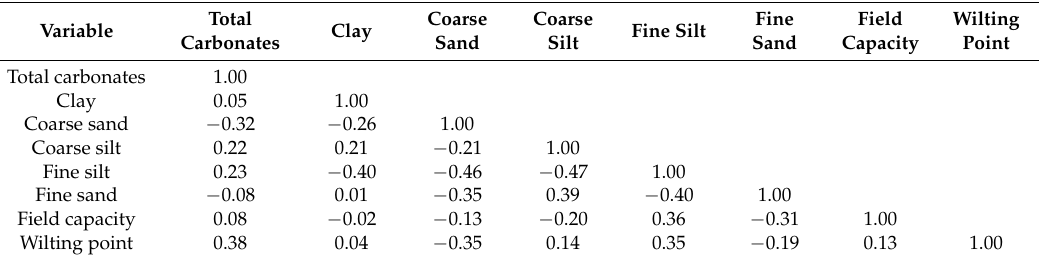
Table 4. Correlation matrix of soil variables.